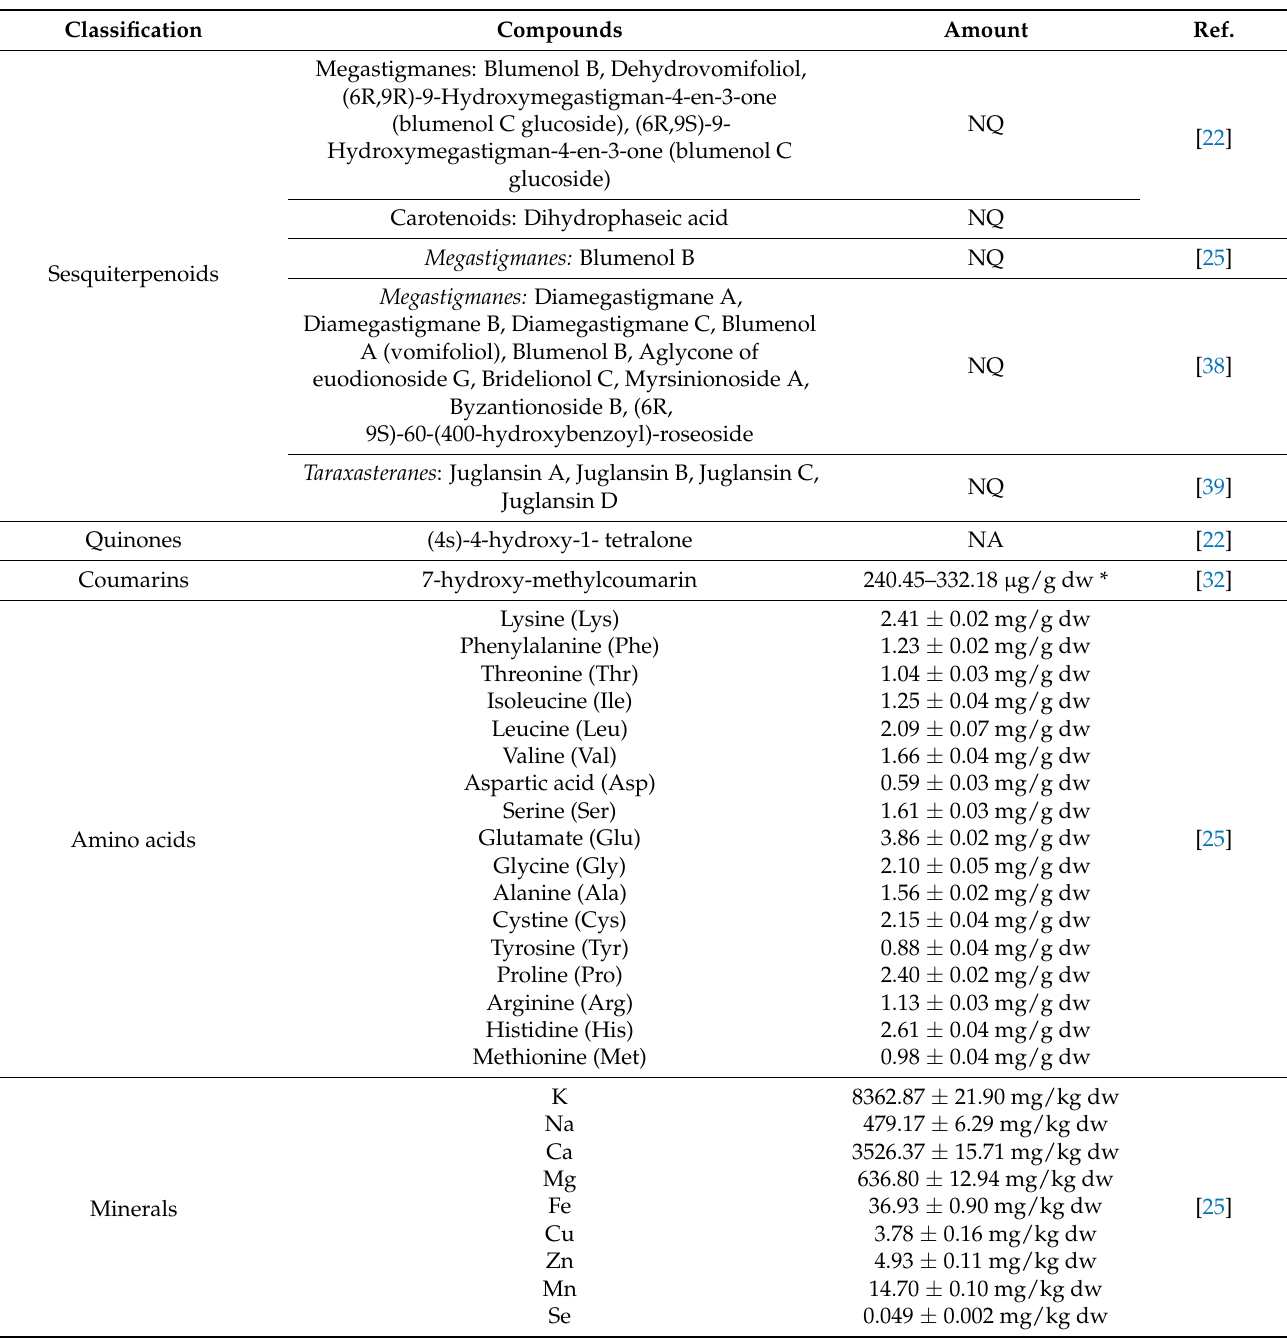
Table 5. Other compounds identified and quantified in walnut septum